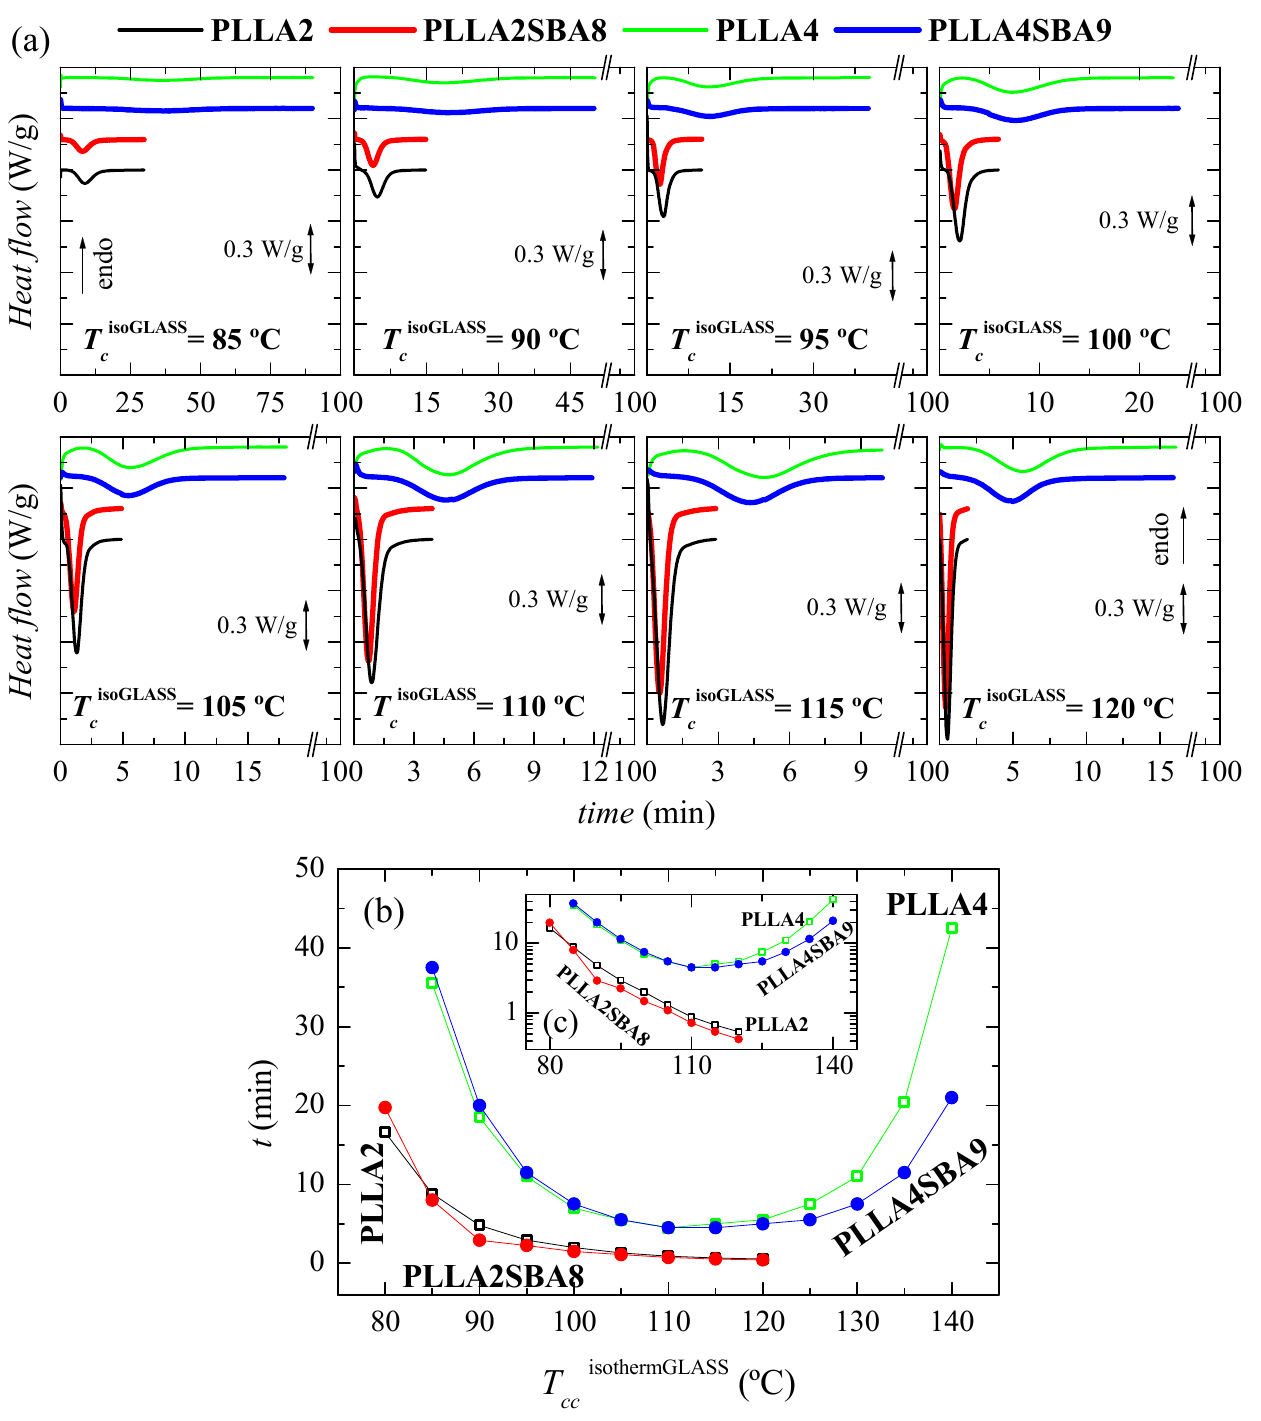
Figure 5. ( a ) Variation with time of heat flow for isothermal cold crystallization from the glass at the different temperatures, T cc isothermGLASS , for the several samples. ( b ) Dependence of time at which peak crystallization appears with the T cc isothermGLASS in the two matrices, PLLA2 and PLLA4, as well as the composites PLLA2SBA8 and PLLASBA9. ( c ) Time as a function of T cc isothermGLASS in logarithmic scale.